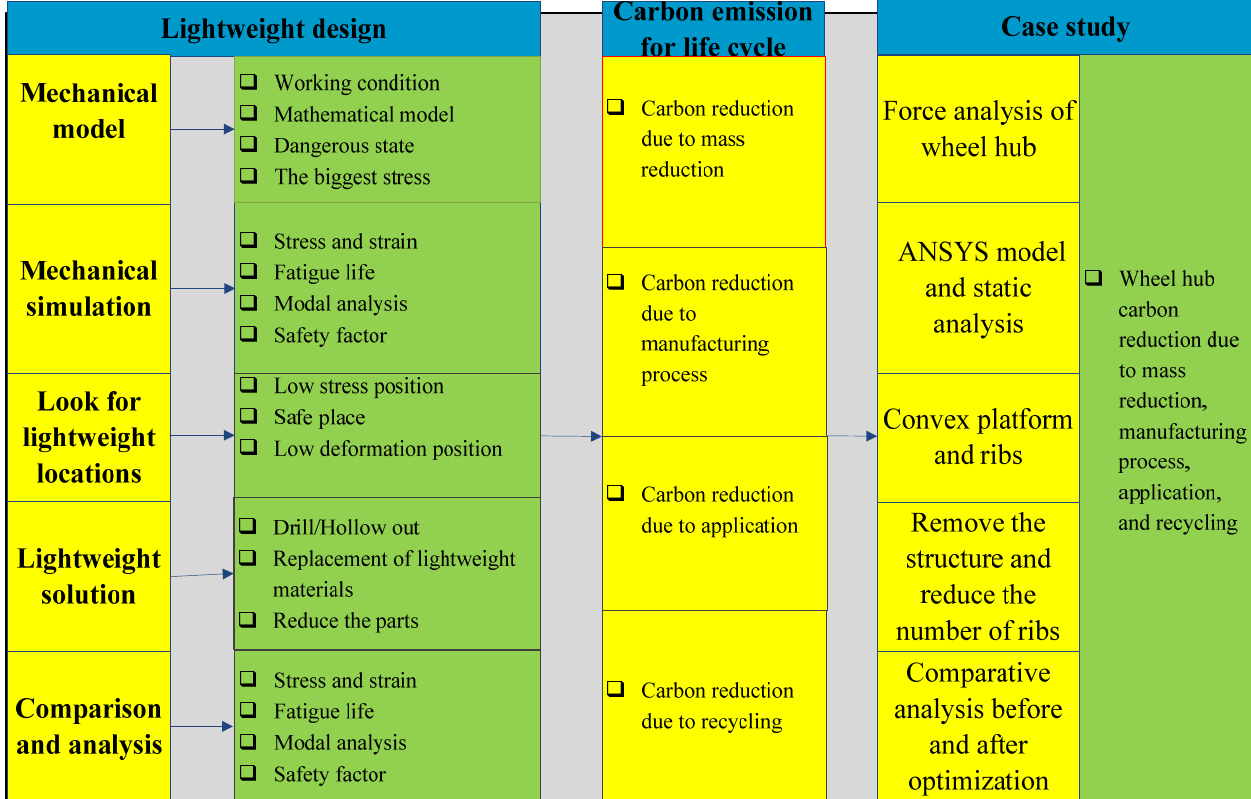
Figure 1. Flowchart of the proposed lightweight design method for carbon emissions.